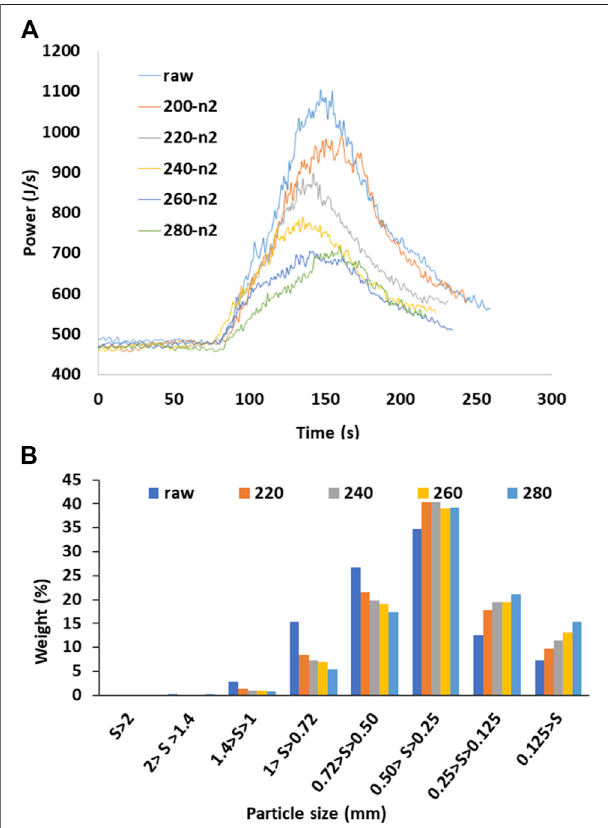
FIGURE 2 | (A) Grinding energy consumption and (B) particle size distribution of untreated and torre fi ed groundwood pellet (Ghiasi, 2019).